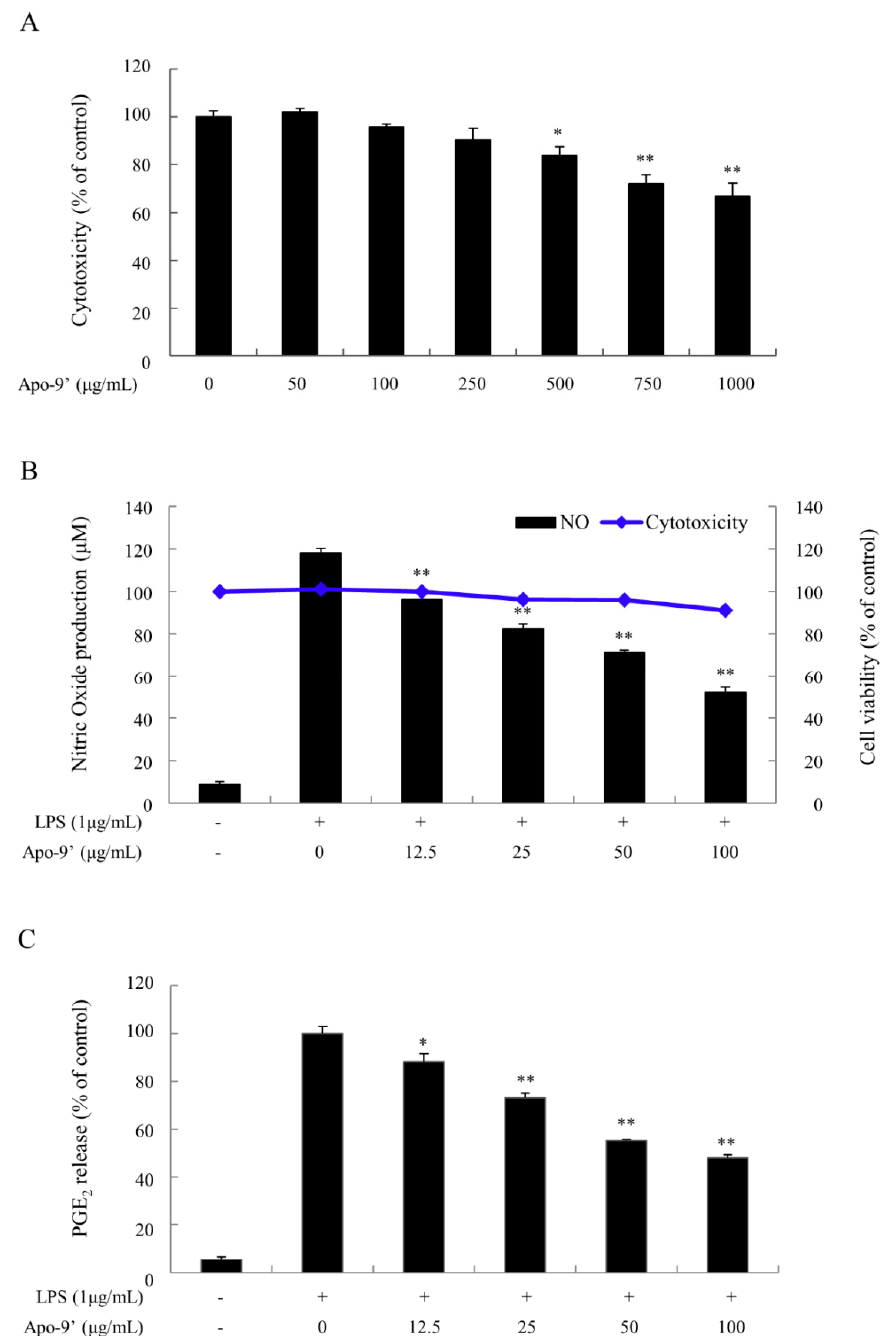
Figure 10. Anti-inflammatory experiments of Apo-9 ′ -fucoxanthinone isolated from S. muticum extract. ( A ) Cytotoxicity of Apo-9 ′ -fucoxanthinone in Raw264.7 cells; ( B ) Cytotoxicity and nitric oxide(NO) expression analysis; ( C ) Prostaglandin E2 (PGE 2 ) expression analysis. *: significantly different from the CIA group ( p < 0.05), **: significantly different from the CIA group ( p < 0.01).